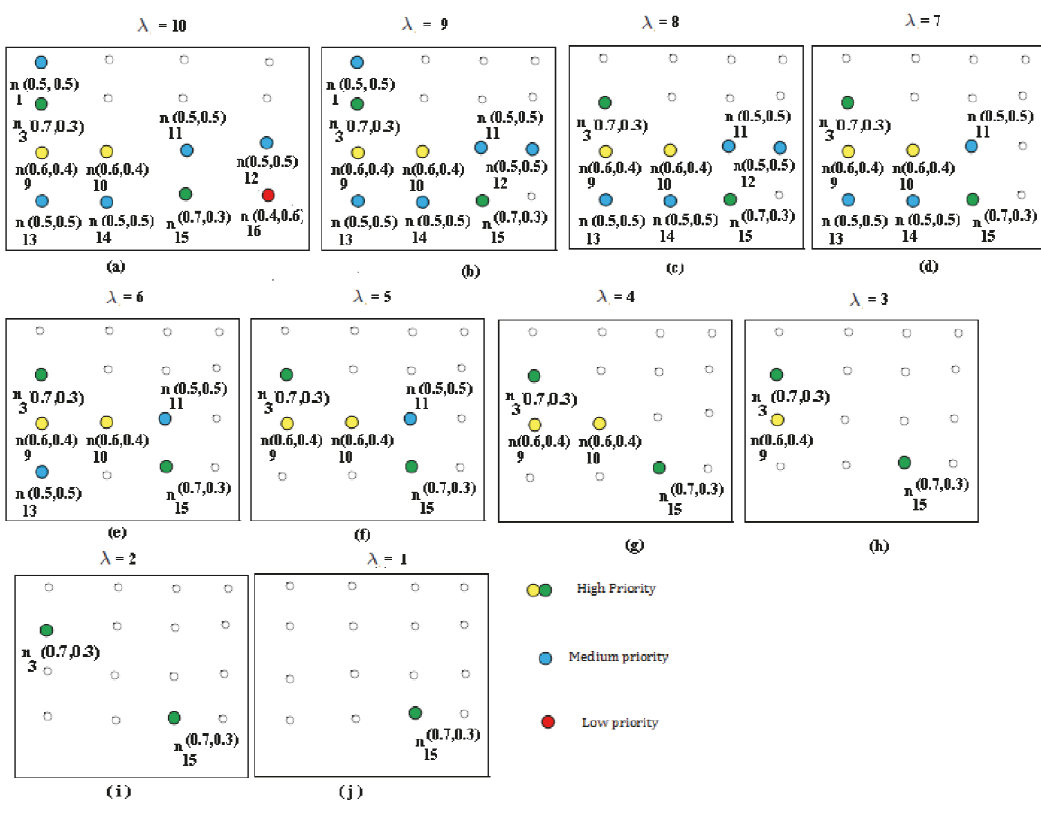
Figure 7: (a)-(j) Metric induced closing 𝜙 𝜆 = [𝜀 𝑛 (𝛿 𝑒 (𝑌 𝑛 ))] 𝜆